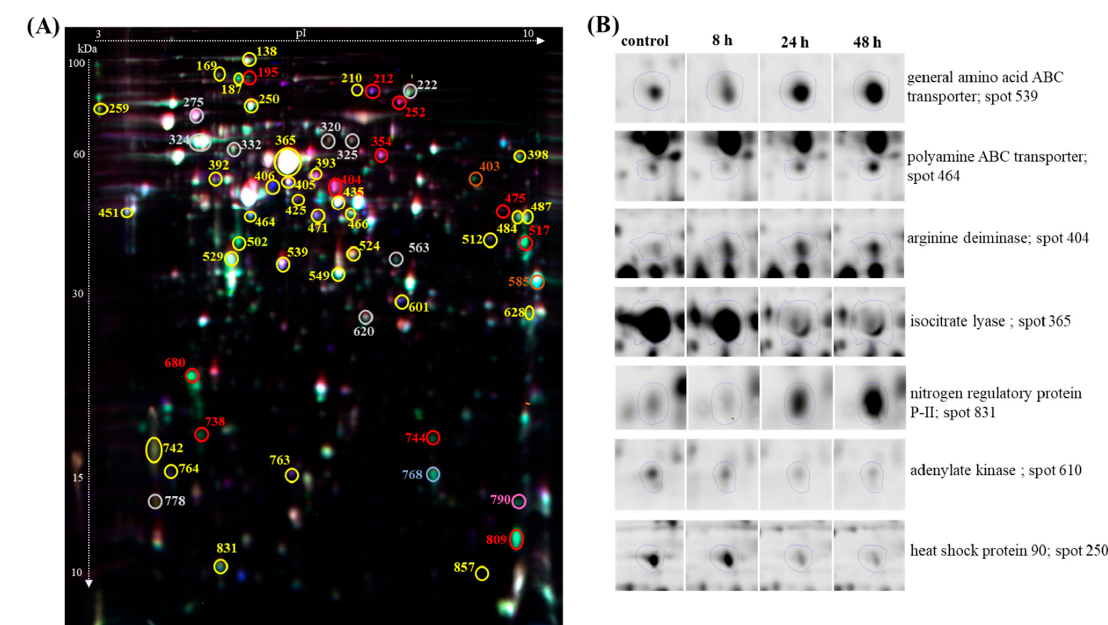
Figure 2. Comparative 2D difference gel electrophoresis (2D-DIGE) analysis of cellular proteins of Pseudomonas putida KT2440. Numbers indicate spots that significantly differ at 8 h, 24 h, and 48 h compared to the control. ( A ) 2D-DIGE gel (overlay images). Red circle indicates proteins more abundant at all time-points, orange circle only at 8 h, pink circle indicates proteins more abundant at 24 h and 48 h, blue circle only at 24 h, grey circle only at 48 h, yellow circle at 24 h and 48 h. ( B ) Examples of normalized DIGE spots.